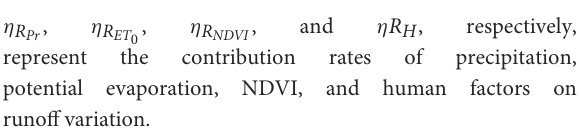
trend ( p < 0.05), with a slope of − 2.5492 mm/a (Figure 2A). During the period of 1982–2015, the runoff depth of the river basin in 2,000 was the maximum (492.05 mm), and the runoff depth in 2012 was the lowest (230.91